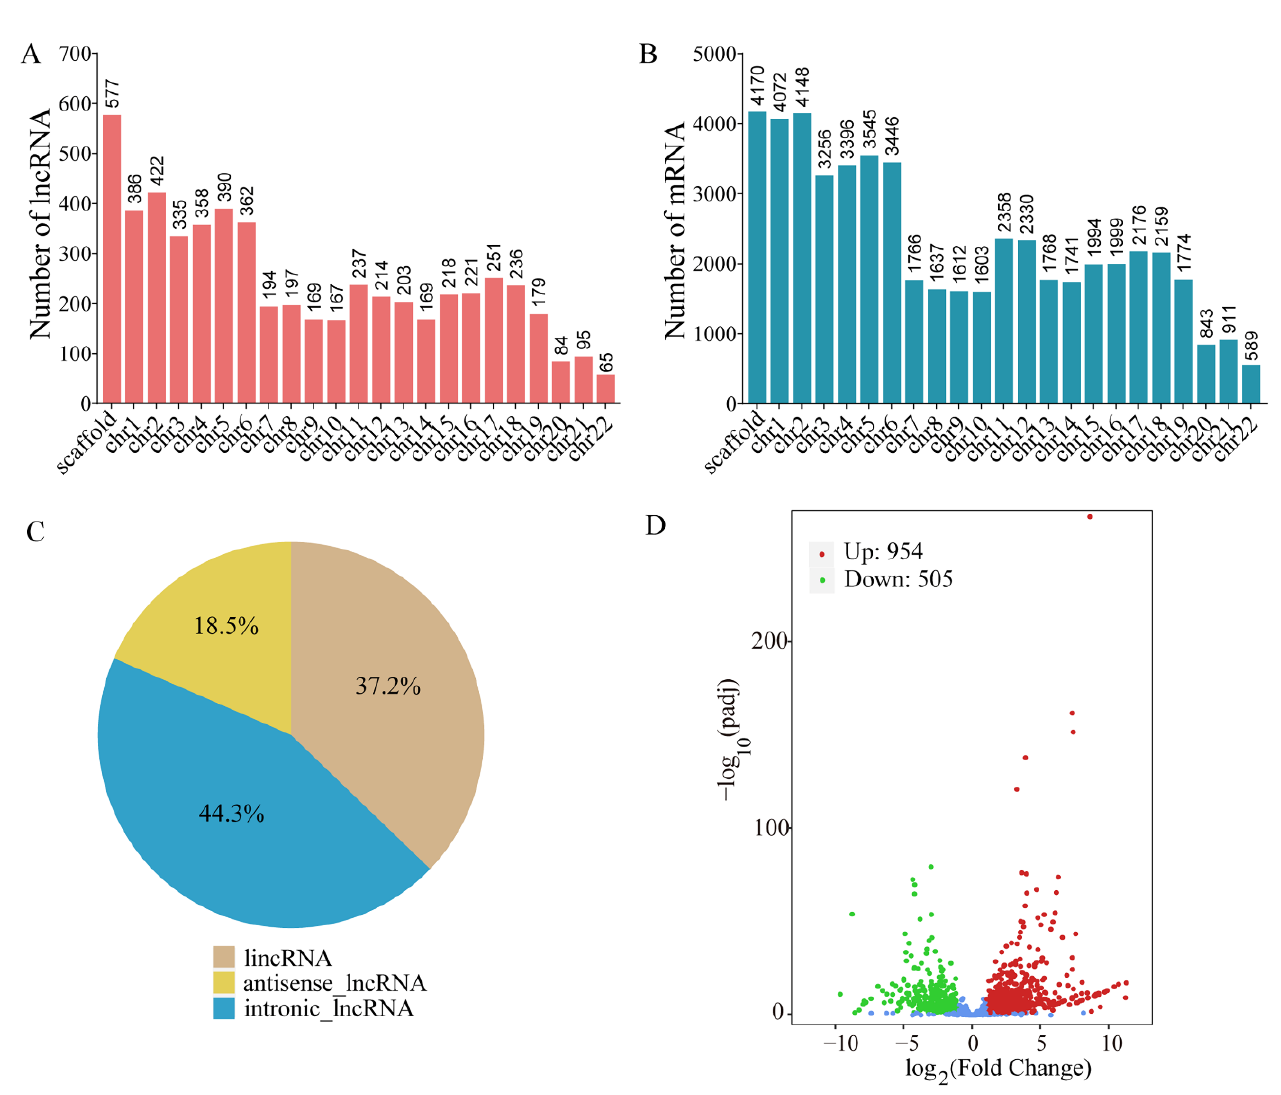
Figure 1. Transcriptome sequencing of the Antarctic moss, Pohlia nutans , under UV-B light. ( A , B ) Distribution characteristics of lncRNA and mRNA on chromosomes. chr1–22 corresponded to 22 pairs of chromosomes. ( C ) The classification of all lncRNAs of P. nutans . ( D ) The volcano plot showing the DELs between UV-B radiation group and the control group. The X -axis indicates fold-change of gene expression (threshold, |log 2 (Treat/Control)| > 1), while the Y -axis means the statistically significant level (threshold, q-value < 0.005). Blue dots represent lncRNA detected but not significantly different.